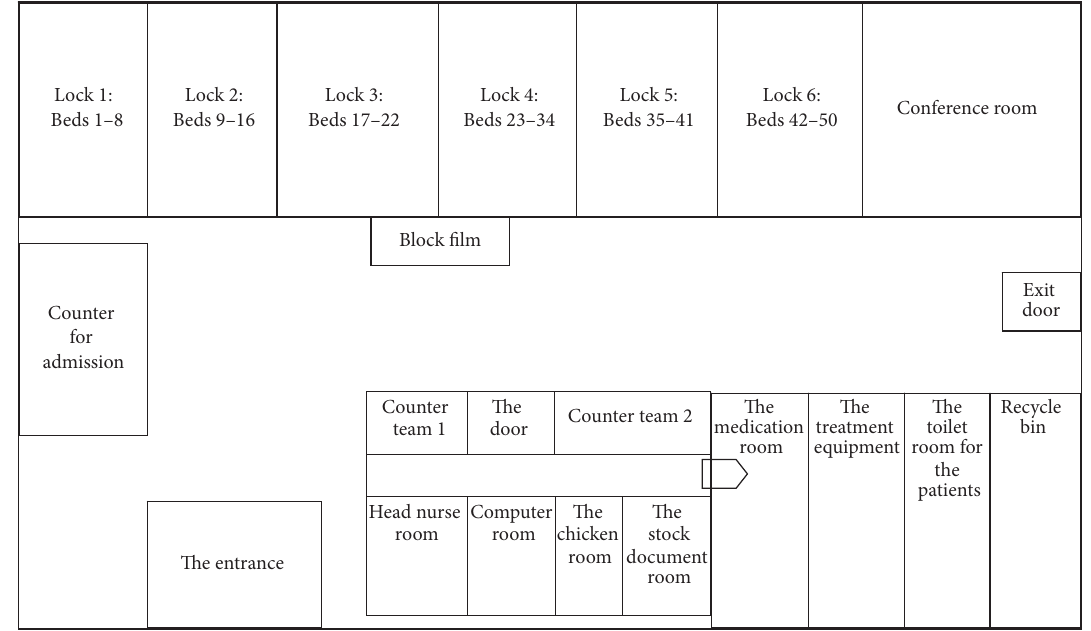
Figure 2: Illustration of the layout of the surgical